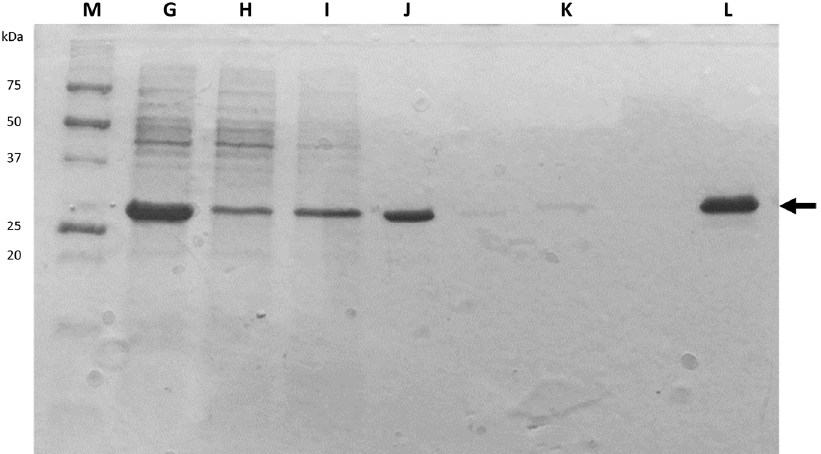
Figure 4. Representative SDS-PAGE gel of the samples collected between cell lysis and protein dialysis (G to L). Lane M corresponds to Precision Plus Protein unstained standards (ref. 161-0363, Bio-Rad). The arrow indicates the bands corresponding to eGFP.